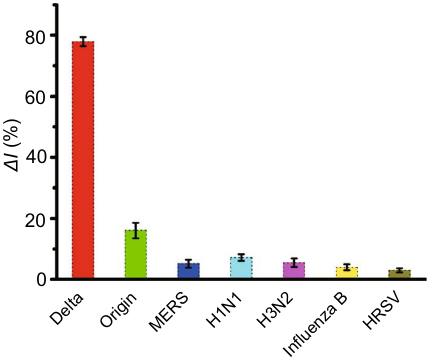
Fig. 4 Specificity analysis of the AuNPs assisted E‑CRISPR for SARS‑COV‑2 Delta variant. The change in signal was calculated based on the SWV current with the addition of the target DNA (10 nM) and non‑target virus (10 nM), respectively. Error bars repre‑ sent standard derivation obtained in three parallel